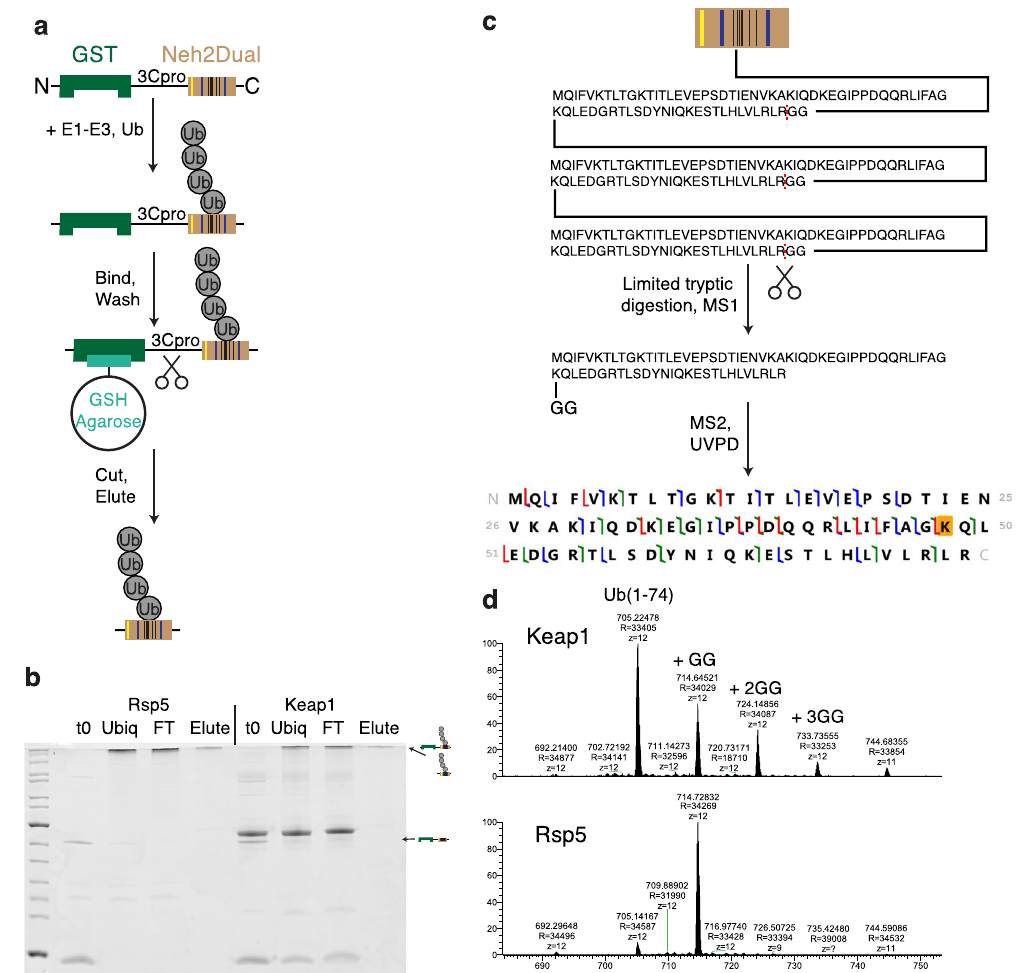
Figure 5. Characterization of Rsp5- and Keap1-ubiquitinated substrates. ( a ) Schematic depiction of GST- Neh2Dual substrate preparation. Yellow bar indicates Rsp5 binding site, blue bars Keap1 binding sites and black bars lysines in the Neh2 domain. Substrate was ubiquitinated with either Rsp5 or Keap1, bound to GSH- agarose beads, washed to remove free ubiquitin chains and components of the ubiquitination reaction, and then eluted by cleavage with GST-tagged HRV 3C protease. ( b ) Coomassie-stained gel showing ubiquitination (t0 is a sample taken immediately after the reaction was initiated by addition of ubiquitin) and purification of the GST-Neh2Dual sample. Final elutions contain almost exclusively polyubiquitinated Neh2Dual with no contaminating free ubiquitin. Strong band just above the full-length substrate in Keap1 lanes is ovalbumin, a component of the ubiquitination buffer. ( c ) Schematic depiction of middle-down mass spectrometry approach. Substrate (shown here as Ub 3 attached to one lysine in Neh2Dual) was subjected to limited tryptic digestion to cleave ubiquitin prior to glycine 75 to generate ubiquitin(1-74) monomers. Here the proximal or middle ubiquitin is shown after digestion; this ubiquitin contains a diglycine appended to K48 that was derived from the distal ubiquitin in the chain. The distal ubiquitin would generate a ubiquitin(1-74) monomer lacking any diglycine modifications. Following cleavage, MS1 was used to identify the number of glycine modifications, and MS2 analysis with UVPD was used to determine the most likely site(s) of modification. ( d ) Ub(1-74) monomers detected for Keap1 and Rsp5. For Keap1, monomers containing between zero and three diglycines were detected, indicating substantial branching, while for Rsp5, only monomers lacking or containing a single diglycine were detected, indicating linear